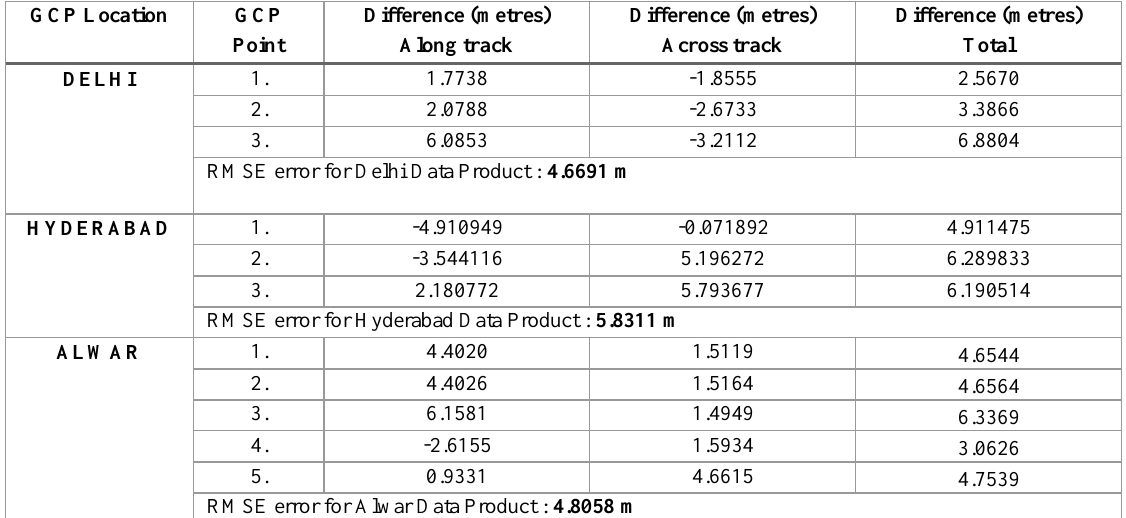
Table 2: Observation Table for data products